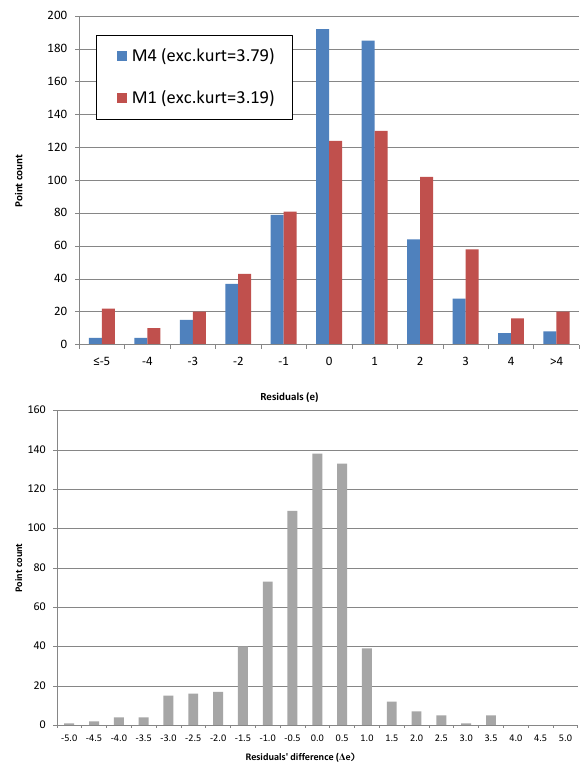
residuals of Model M1 and M4, as well as ANN residuals’ difference between M4 and ANN